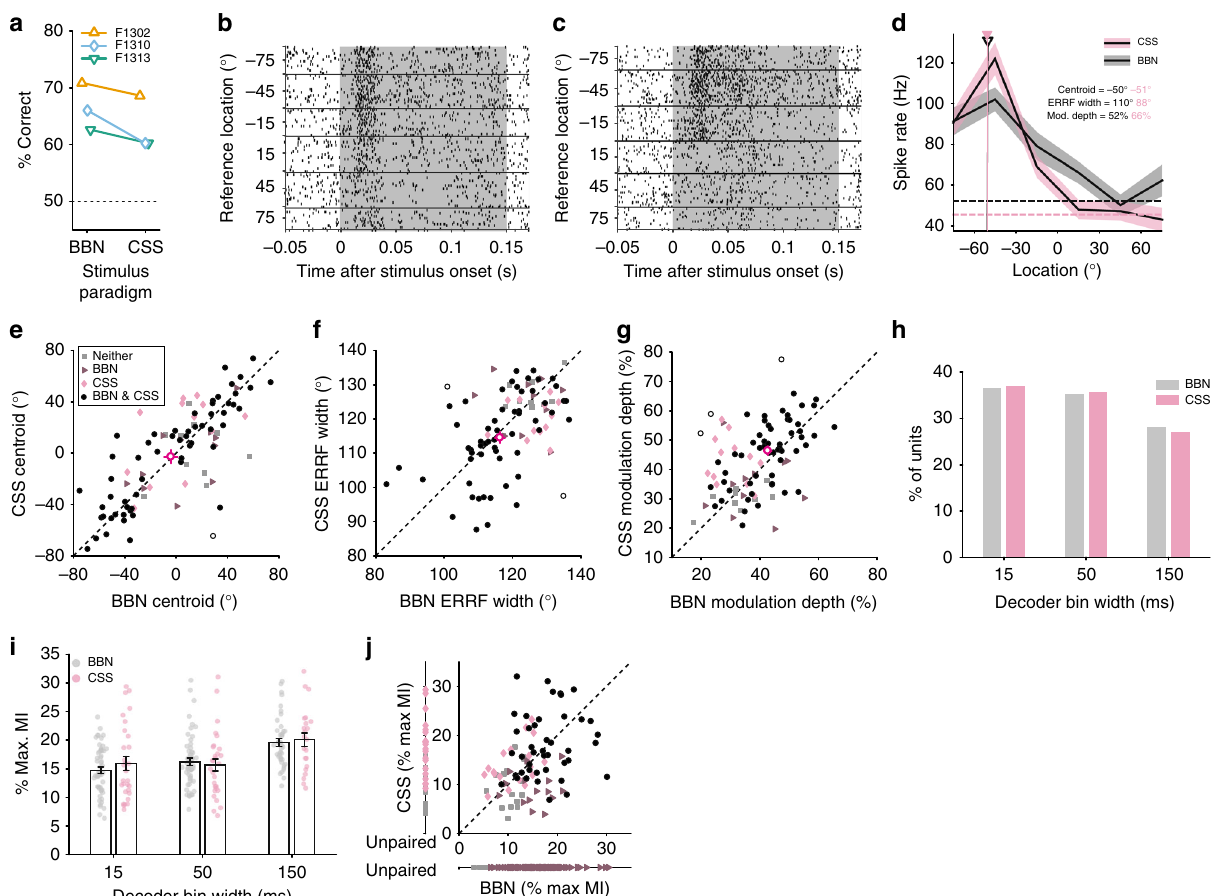
Fig. 6 Spatial tuning properties in the presence of a competing sound source. a Performance in the relative localisation task in broadband conditions (BBN) and in the presence of a competing sound source (CSS) for each ferret. b Example, raster in response to BBN stimuli and ( c ) CSS stimuli. d Spatial receptive fi elds of the same unit with centroids indicated by triangles. Spontaneous fi ring rates are indicated by the dotted lines. e Centroids, ( f ) ERRF widths and ( g ) modulation depth of units recorded in both BBN and CSS conditions. Mean± s.e.m. (standard error of the mean) of units signi fi cantly spatially modulated in both conditions (black circles, N = 59) is shown by magenta cross-hairs. Open circles show individual units that changed signi fi cantly between the BBN and CSS conditions. Units signi fi cantly spatially modulated in a single condition are shown by the triangles (BBN, N = 11) and diamonds (CSS, N = 12). Grey squares were units not signi fi cantly spatially modulated in either condition ( N = 10). h Distribution of best bin widths for all signi fi cantly spatially informative units (BBN, N = 153; CSS, N = 81). i Mean maximum MI ± s.e.m. of units from ( g ). The raw data are shown in coloured circles. j Comparison of MI in units recorded in BBN and CSS conditions. Black circles indicate units with signi fi cant MI in both conditions ( N = 43), units with signi fi cant MI in a single condition are shown by triangles (BBN, N = 15) and diamonds (CSS, N = 18). Grey squares did not have signi fi cant MI in either condition ( N = 16). Units that were only recorded in one condition are plotted along a separate axis (labelled unpaired, BBN sig. N = 95, not sig. = 66. CSS sig. = 20, not sig. =